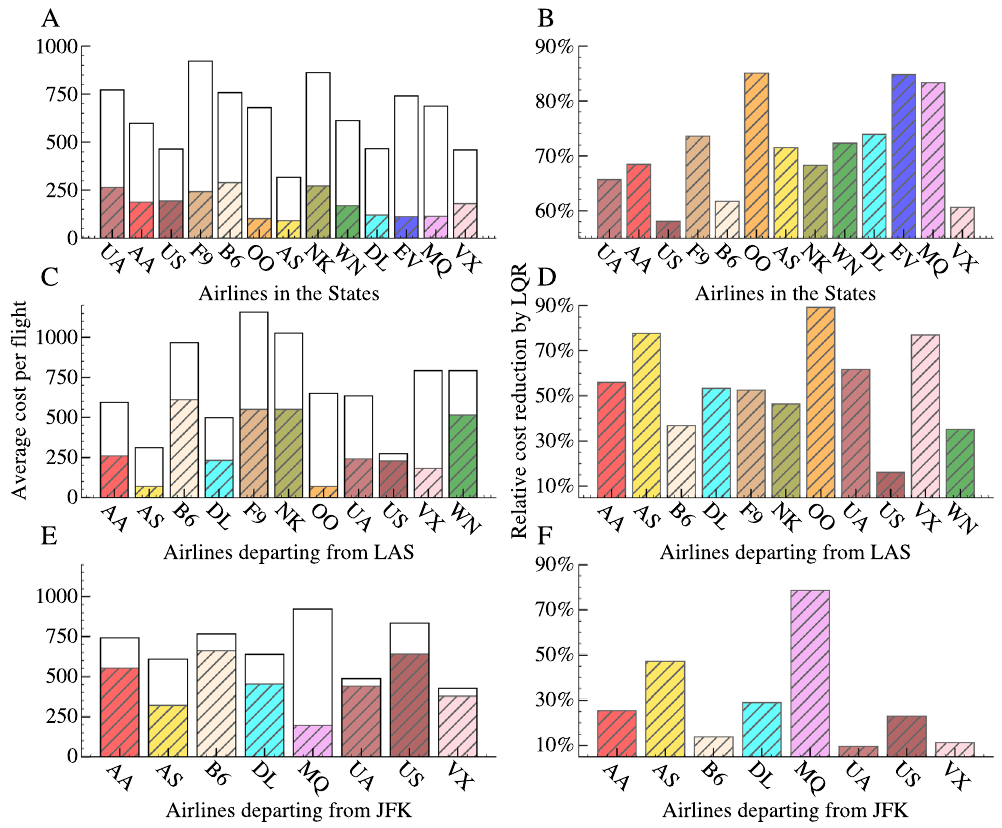
Figure 4. Reduction in delay cost by the optimal control LQR on airlines in the United States and airlines departing from two airports LAS and JFK. ( A, C, E ) The total cost per flight with and without control for each airline. The shaded areas represent costs with control and the blank areas represent costs saved by LQR. ( B, D, F ) The relative percentage of the saved costs by